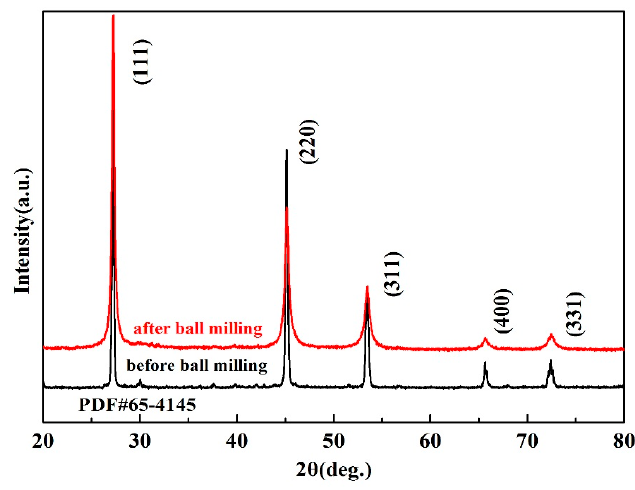
Figure 3. The XRD patterns of Cu 2 SnSe 3 powder before and after ball milling.